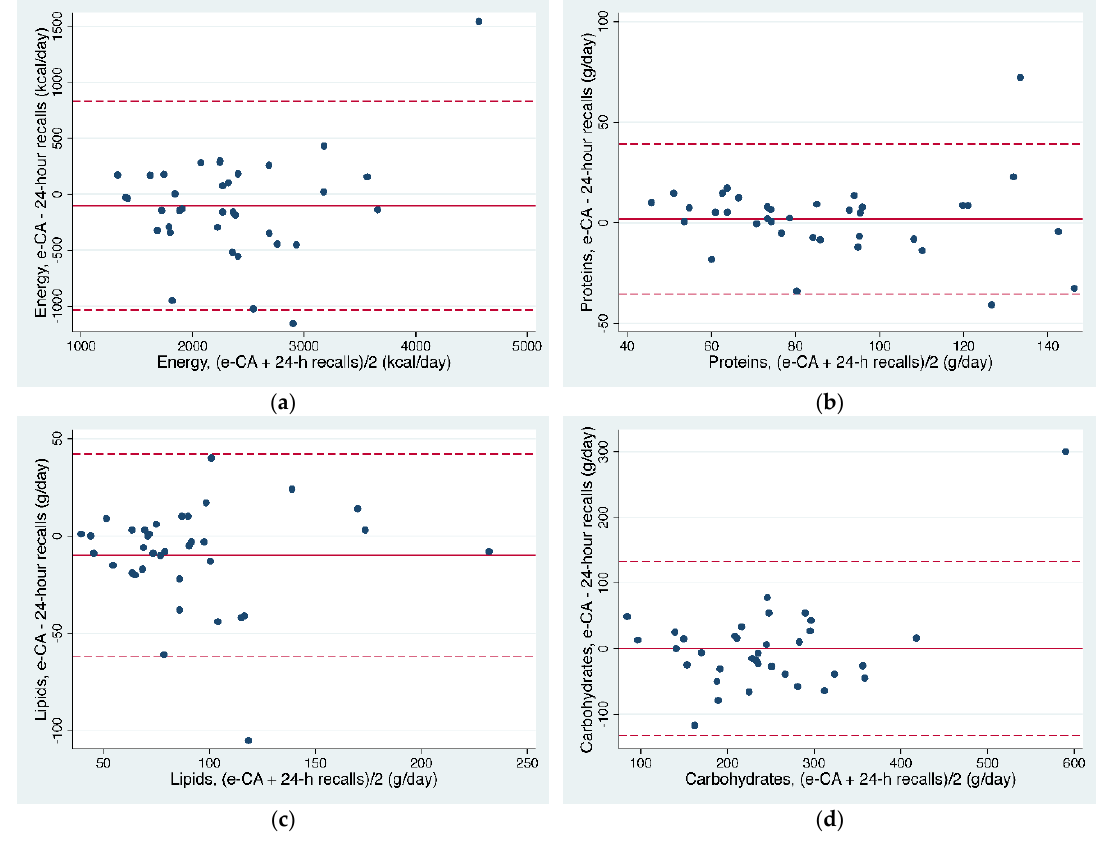
Figure 3. Bland ‐ Altman plots of the mean difference (plain line) between e ‐ CA and 24 ‐ h recall versus the mean intake of the two methods for energy ( a ), protein ( b ), lipid ( c ), and carbohydrate ( d ) intakes. The limits of agreement (dashed lines) equal 2 standard deviations above and below the mean difference